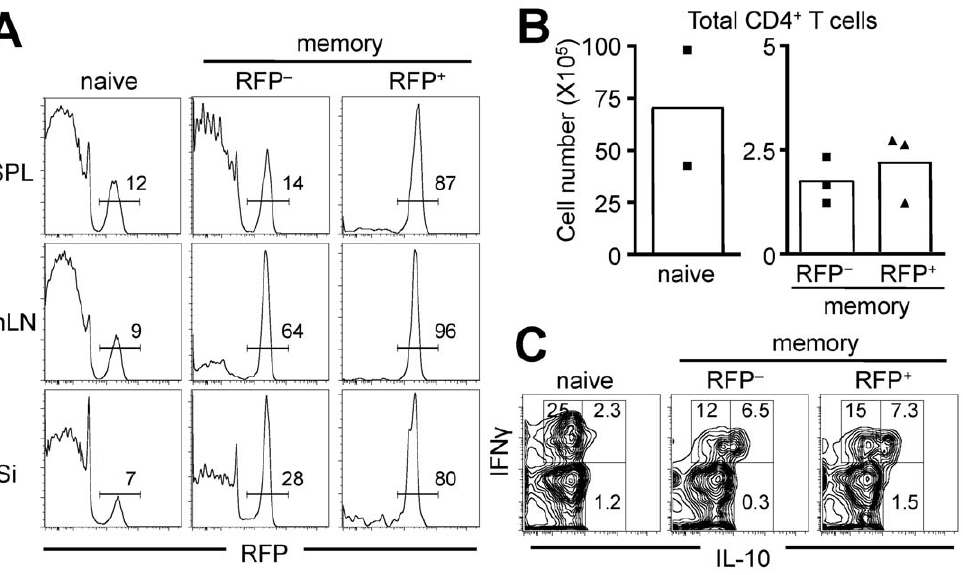
Figure 7. Generation of exAID CD4 + T cells invivo by Adoptive transfer to CD3 e 2 / 2 mice. (A) RFP expression of CD4 + T cells recovered from spleen, mesenteric lymph node, and small intestine of CD3 e 2 / 2 mice transferred indicated phenotype of T cells. (B) CD4 + T cells that were recovered from the spleen, mesenteric lymph node, Peyer’s patch, small intestine and large intestine of the mice transferred RFP 2 EM (n=3; square) and RFP + EM CD4 + T cells (n=3; triangle) as well as naı¨ve T cells (n=2; square) were pooled; the total number of cells was counted and plotted. Average numbers are shown by column graphs. (C) IFN- c and IL-10 double producing cell from EM CD4 + T cells after the adoptive transfer. IFN- c and IL-10 expression in spleen CD4 + T cells obtained from T-cell-transferred CD3 e 2 / 2 mice were analyzed by intra-cellular cytokine staining. Recovered cells were stimulated with PMA and ionomycin for 4 hours before the staining. SPL, spleen; mLN, mesenteric lymph node; Si, small intestine; memory, effector